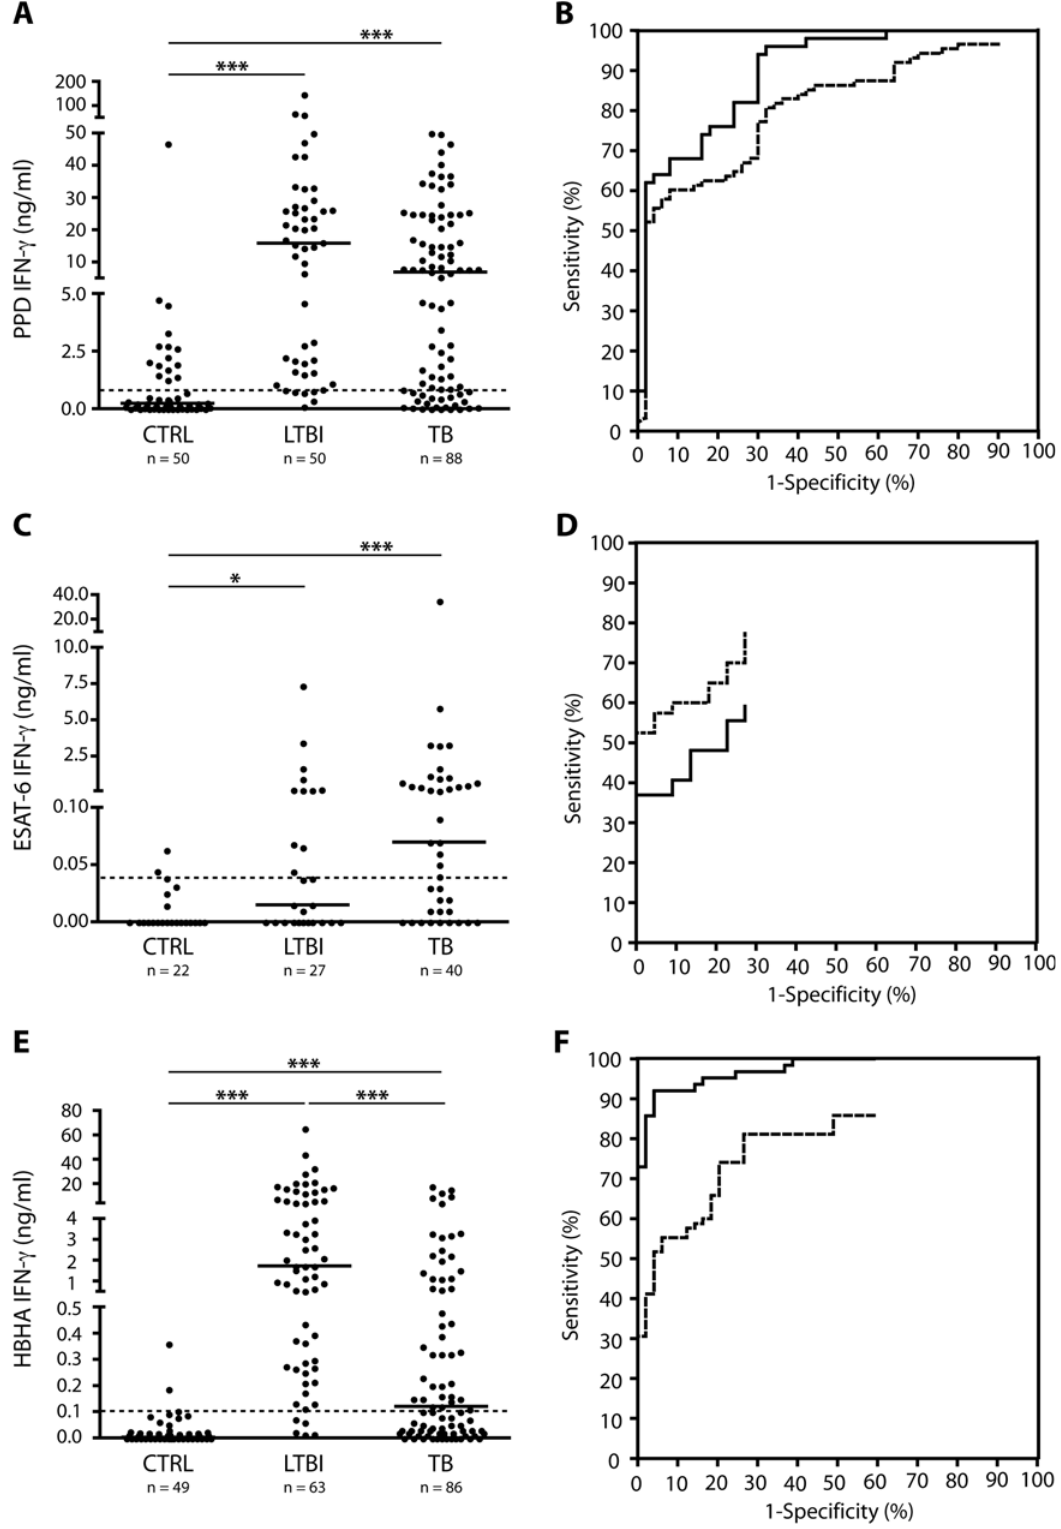
Figure 1. PPD, ESAT-6, and HBHA-induced IFN- c concentrations and ROC analysis of the results. Results of the IFN- c ELISA obtained for three different groups of subjects: non-infected controls (CTRL), subjects with latent M. tuberculosis infection (LTBI) and patients with active tuberculosis (TB) are represented on the left part of the figure. PBMC were in vitro stimulated with different antigens, PPD (A), ESAT-6 (C) and HBHA (E) and the IFN- c concentrations were measured in 96 h cell culture supernatants. The horizontal dotted lines represent the cut-off for positive values as determined by ROC curves analysis, whereas the horizontal filled lines represent the medians of the results. ROC curves established for each antigen are represented on the right panels (PPD, B; ESAT-6, D; HBHA, F). The filled lines represent the curve established for LTBI compared to CTRL, whereas the dotted lines are those established for TB compared to CTRL. *, P , 0.05; ***, P , 0.001. doi:10.1371/journal.pone.0000926.g001 PLoS ONE | www.plosone.org